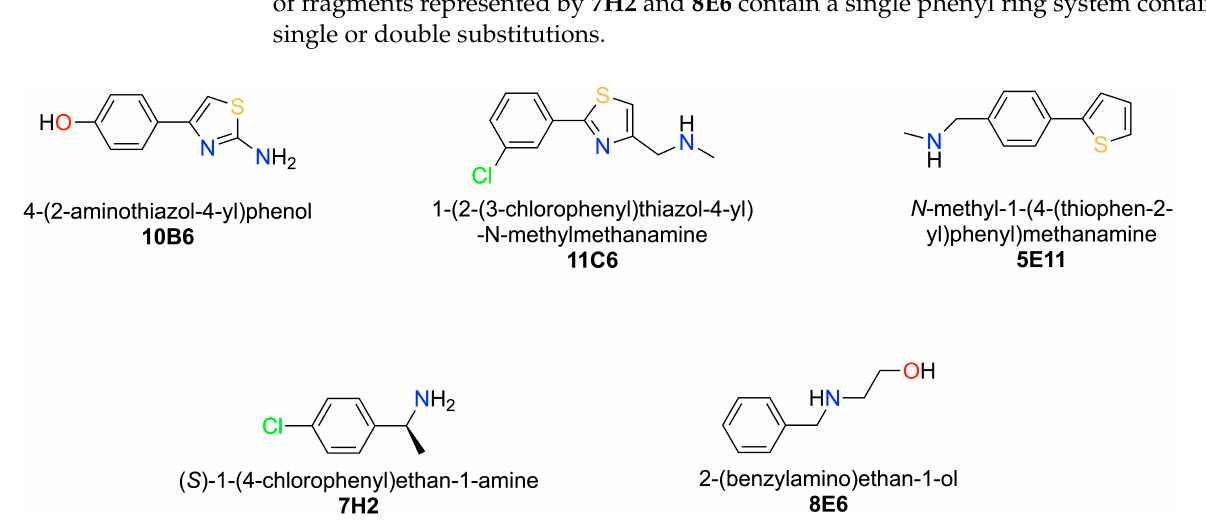
Figure 2. Chemical structures, systematic names and plate positions and of fragment hits binding to two distinct binding sites in SARS-CoV-2 nsp1 10-126 .